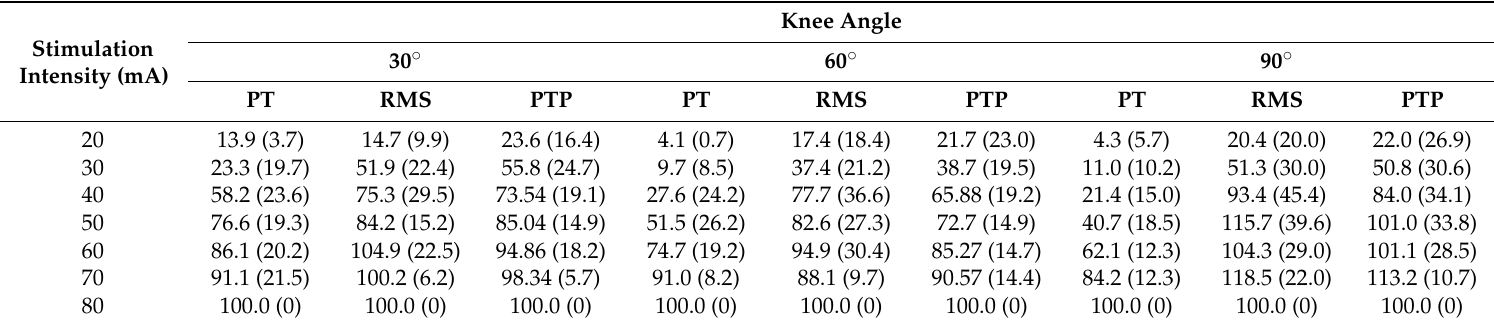
Table 2. Summary of the datasets: Mechanomyographic signal (MMG) characteristics at seven Neuromuscular Electrical Stimulation (NMES) intensities, at three knee angles and their respective peak torque